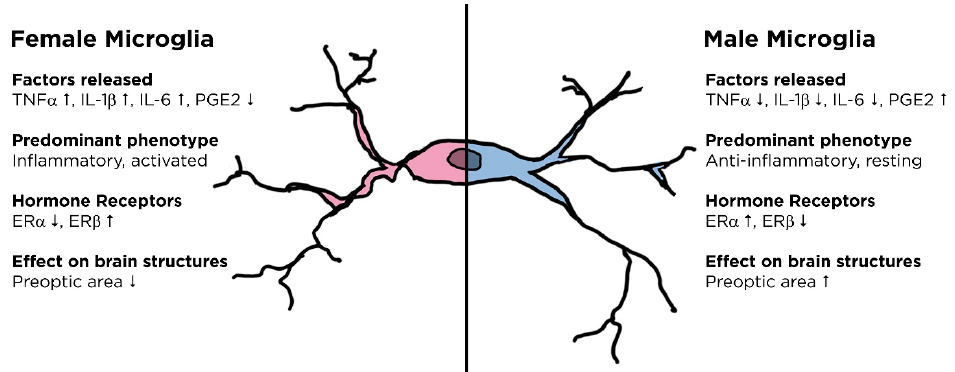
Figure 2. Gender-related disparities in microglial function. All comparisons are relative to microglia of the opposite gender. TNF α , tumor necrosis factor alpha; PGE2, prostaglandin E2; ER, estrogen receptor.